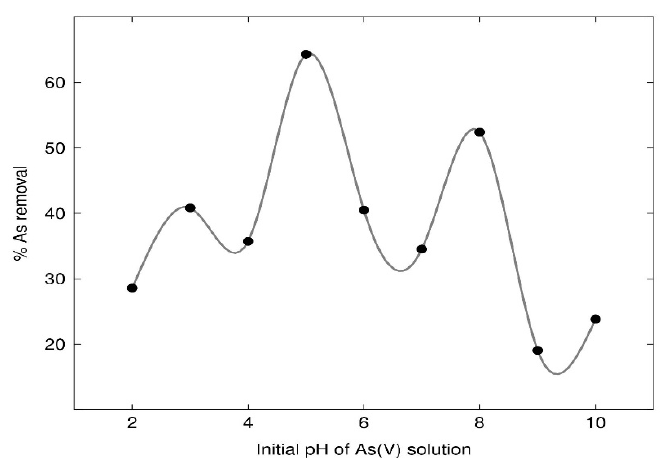
Figure 5. Effect of pH on the adsorption of As(V) (Conditions: pH = 2–10, contact time 8 h, dose 2 g/L (100 mg/50 mL) and As concentration 100 µg/L). 2 g/L (100 mg/50 mL) and As concentration 100 µ